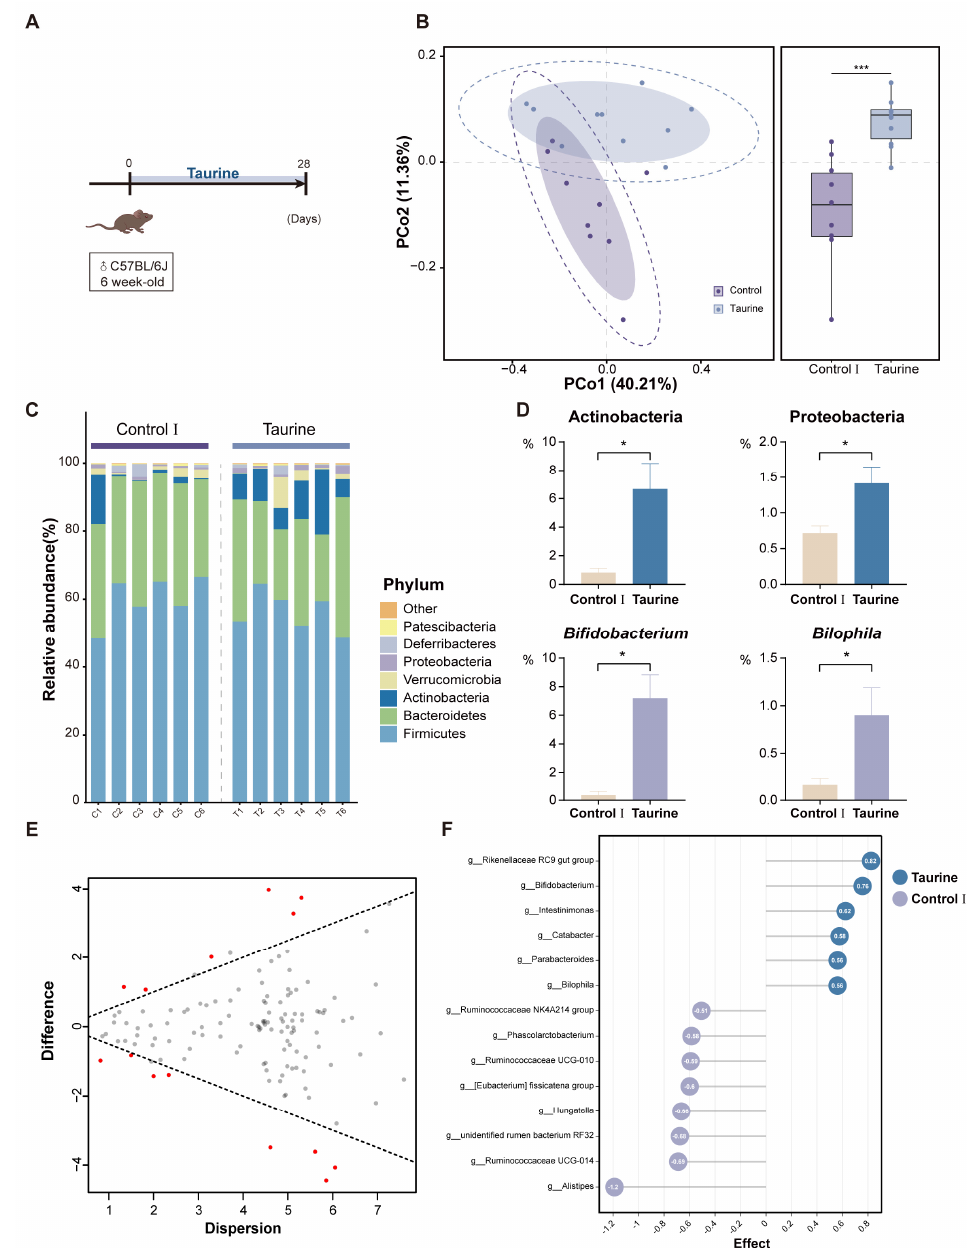
Figure 2. Taurine supplementation regulates the composition of gut microbiota in healthy mice. ( A ) Schematic diagram of the experimental design. ( B ) The Bray − Curtis − based principal coordinate analysis (PCoA) of gut microbiota. The boundary of the dotted ellipse: 95% confidence interval (CI); the shadow ellipse: 80% CI. Box plot center line: median; error bars: minimum to maximum. ( C ) Relative abundance of fecal microbiota at the phylum level. ( D ) Relative abundances of significantly altered phyla (top panel) and genus (bottom panel). ( E ) Effect plot between Taurine and Control Ⅰ group based on Aldex2. Features that are statistically significant are in red and those that are non − significant are in grey. ( F ) Aldex2 analysis of differences in the microbial taxa (Effect size > 0.5). Data are presented as the means ± SEM (n = 8). * p < 0.05 and *** p < 0.001 by unpaired two − tailed Student’s t − test.